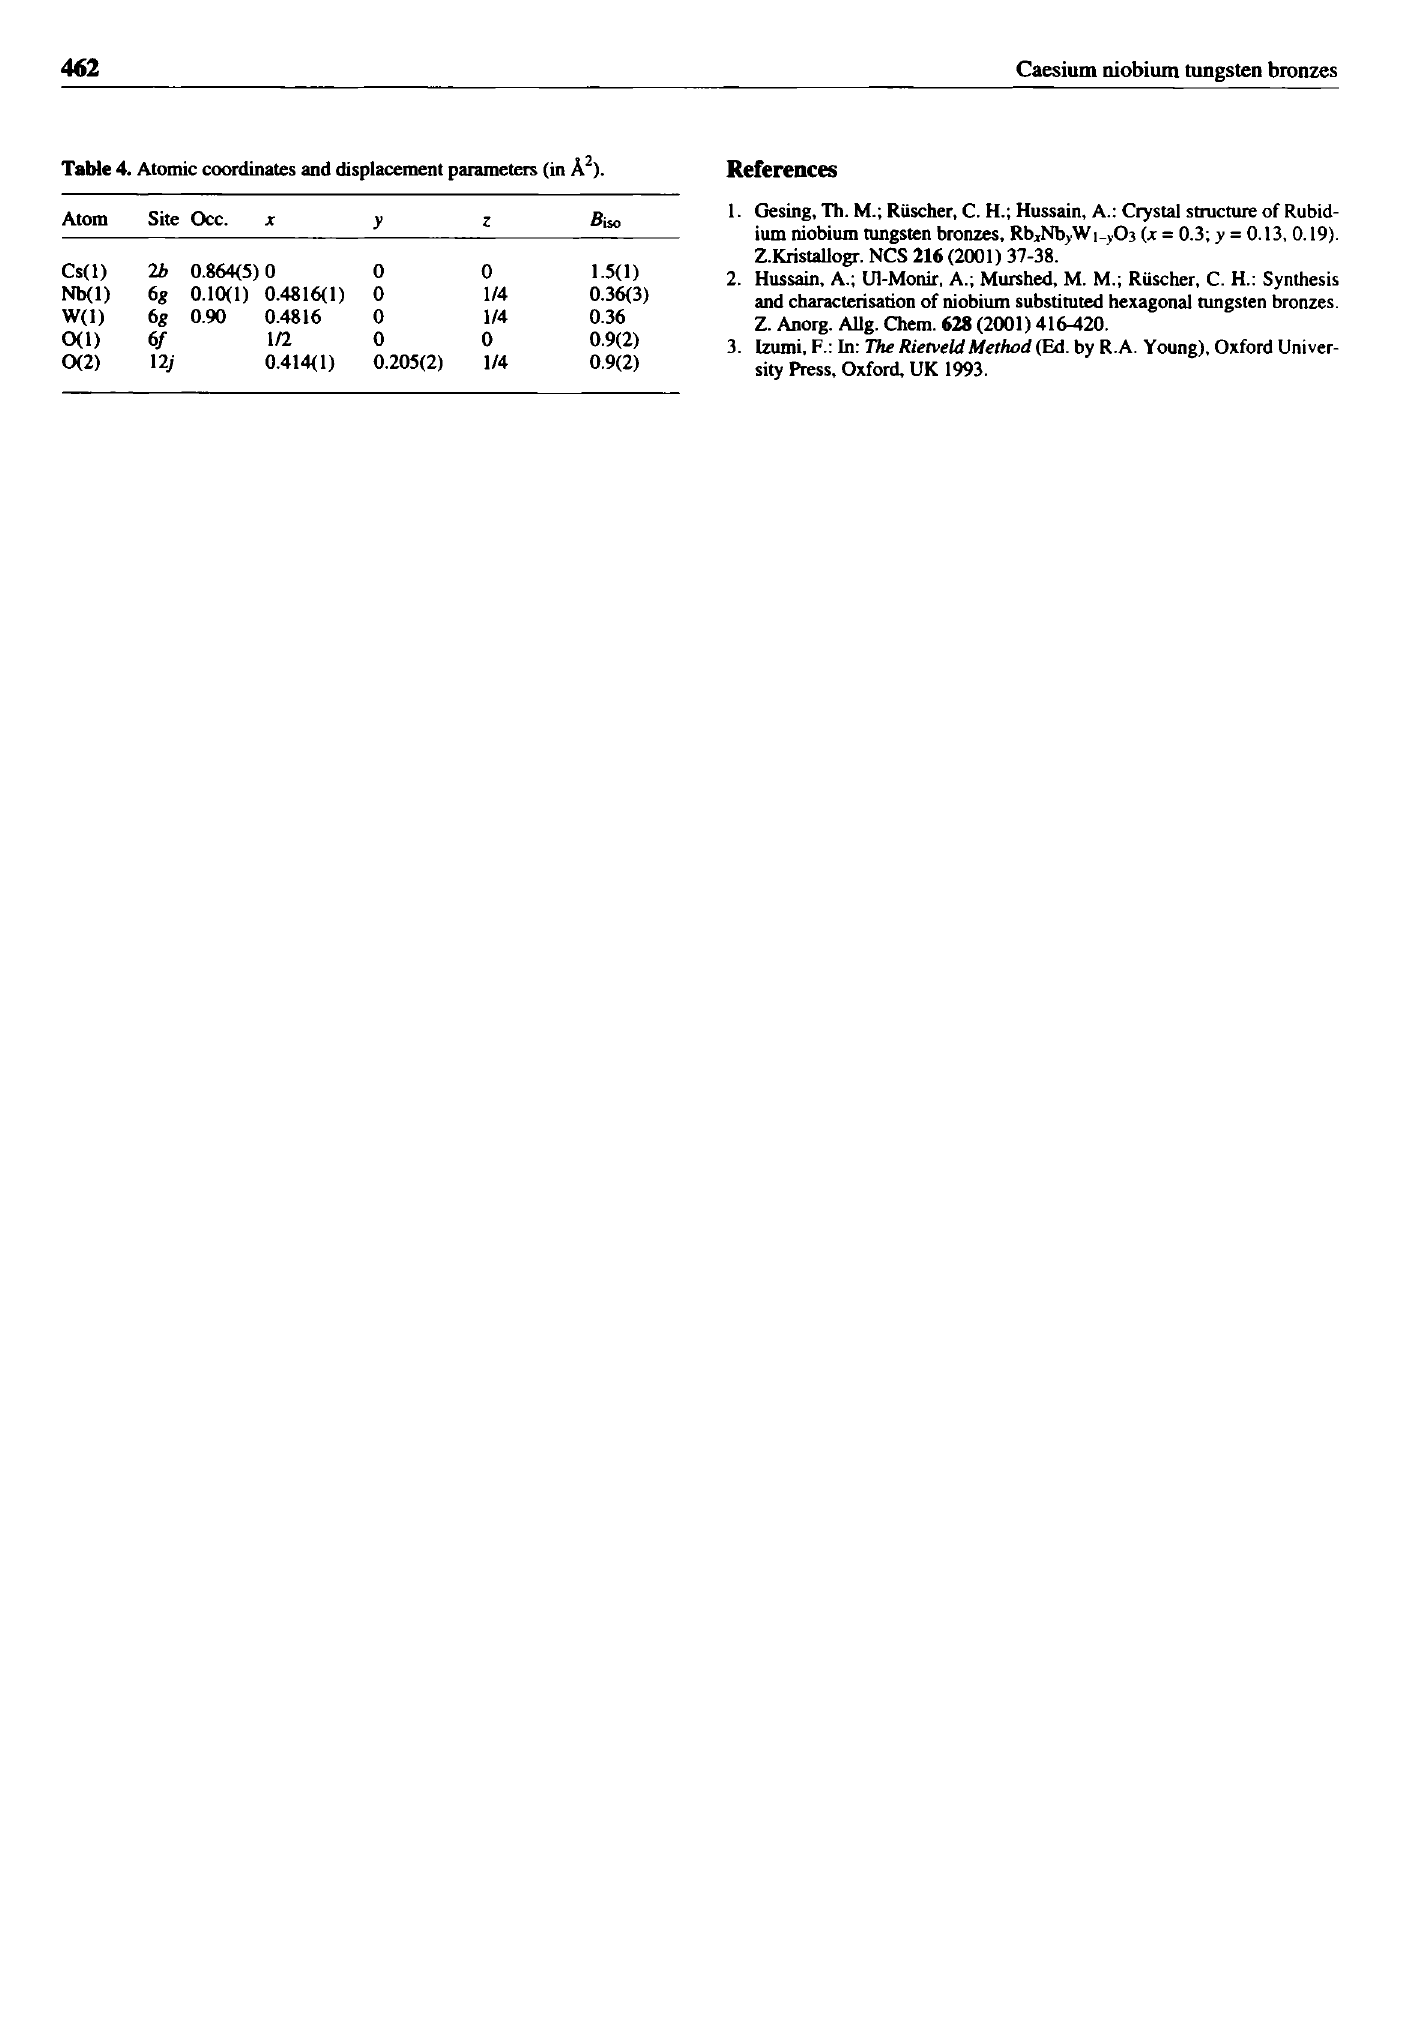
Table 4. Atomic coordinates and displacement parameters (in A 2